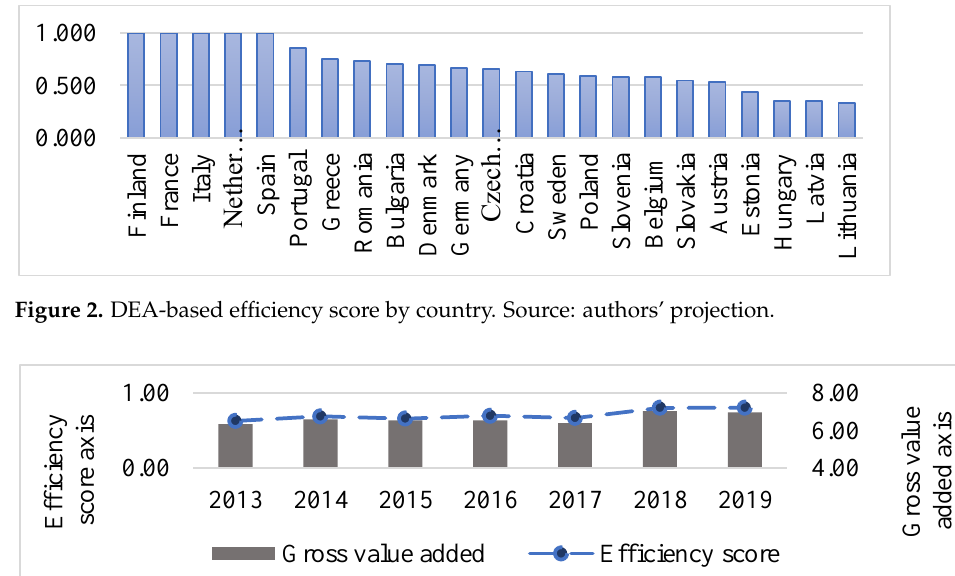
Figure 2. DEA- based efficiency score by country. Source: authors’ projection.